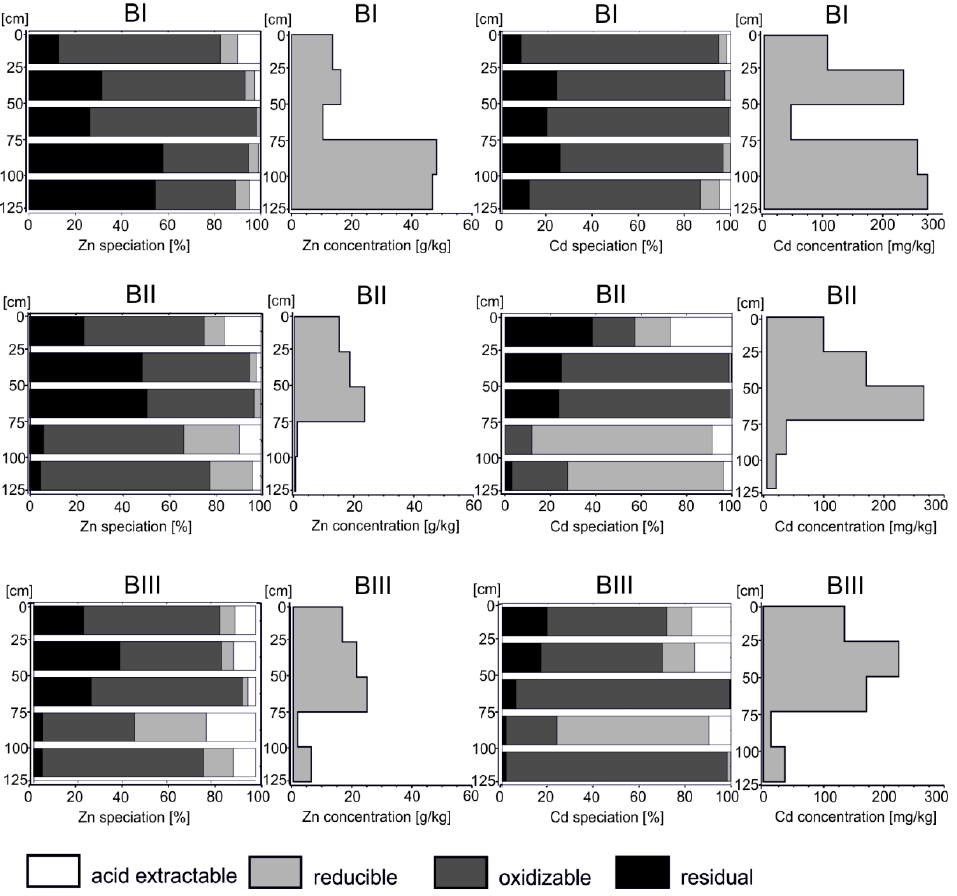
Figure 4. Zn and Cd content and speciation in the Bia ł a River sediments.